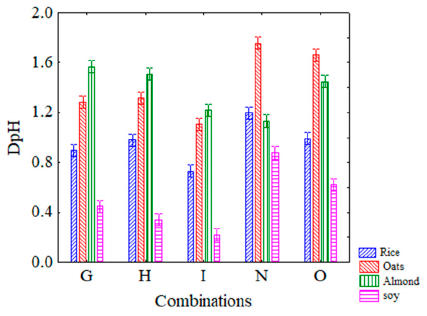
Figure 4. Decomposition of the statistical hypothesis for the interaction combinations vs beverages on acidification. Bars denote 95% confidence intervals. For the code of US treatments see Table 1.